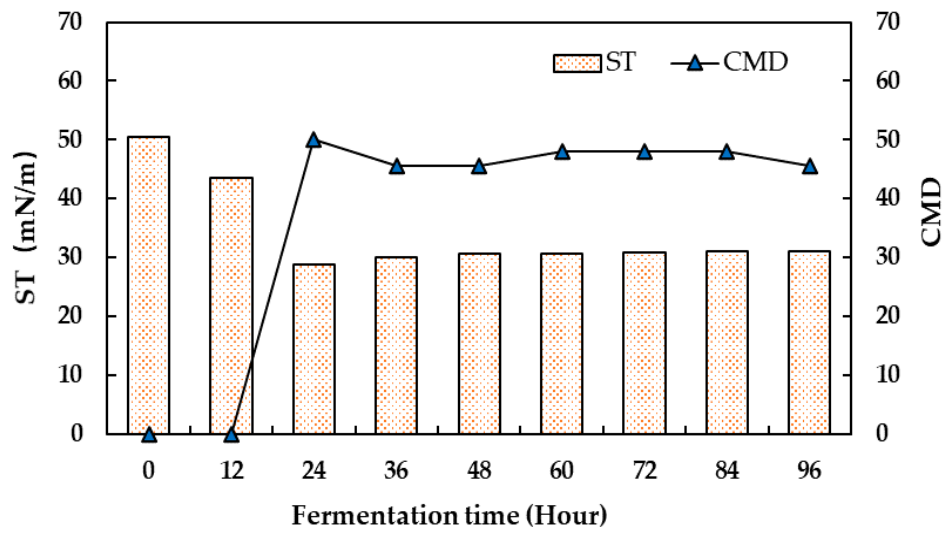
Figure 3. ST and CMD values in batch-scale experiments (7 L) with optimized